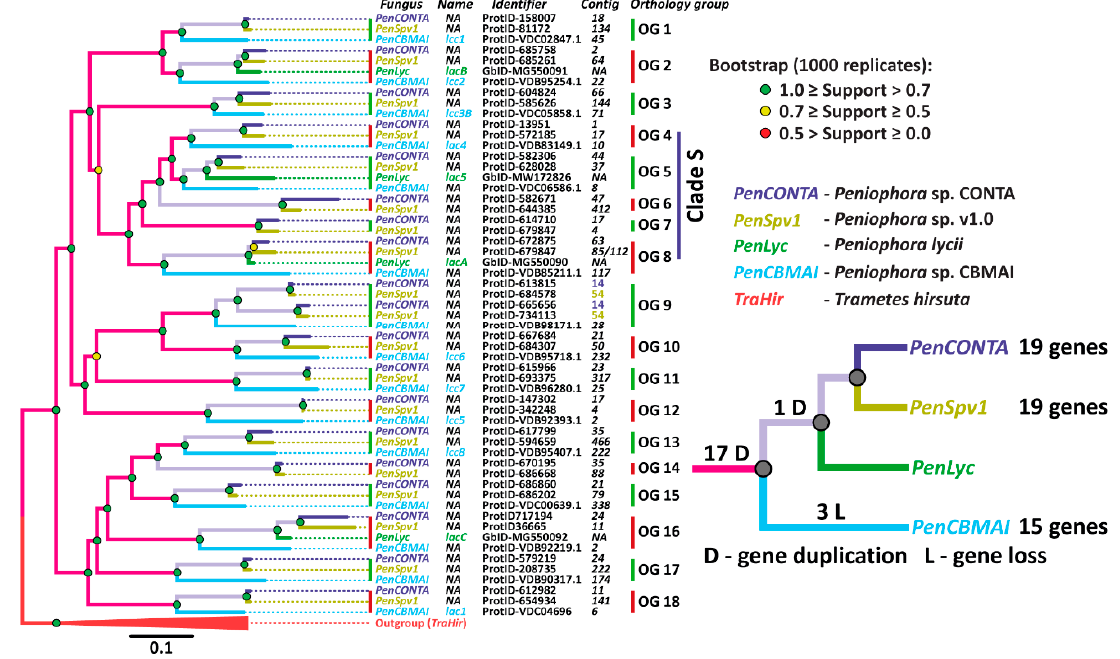
Figure 1. The phylogenetic relationships among laccases of Peniophora spp. The clades which form orthology groups are designated as OG. The clade containing laccases secreted by P. lycii (Lac5, Lac7, LacA) is designated as Clade S. For the laccases obtained from sequenced genomes, protein IDs (ProtID) are used as gene identifiers, while for other laccases, GenBank accession number (GbID) are provided.